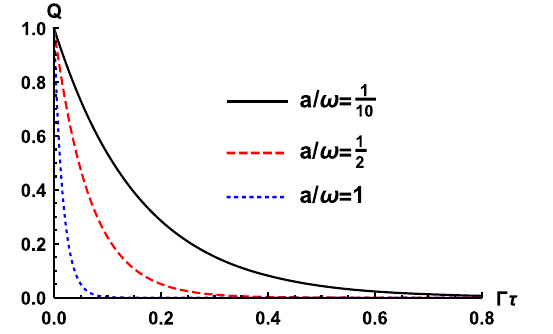
Fig. 1 QC as function of Γ τ with different accelerations for the object is polarized along the x axis and y axis ( ˆ q 11 = −ˆ q 22 = 1 √